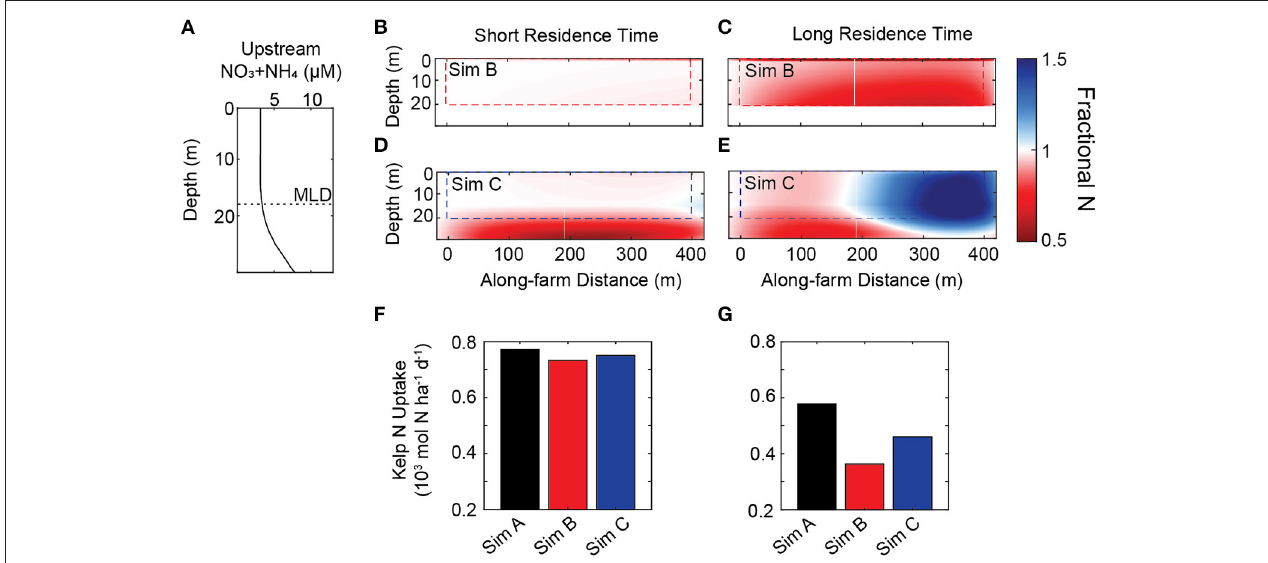
FIGURE 6 | Effect of within-farm nutrient environment on kelp uptake. (A) Upstream nutrient profile used for both residence time demonstrations. Dashed horizontal line indicates depth of the mixed layer. Panels (B–E) illustrate the along-farm fractional change in dissolved nitrogen (NO 3 +NH 4 ) between Simulations B or C relative to upstream conditions on the x − z plane with either short (0.3 h) or long (10 h) residence times on the farm. Simulation B has horizontally-homogeneous transport and kelp uptake effects on nutrient fields. Simulation C includes all within-farm physics, transport, and uptake. Values less than one indicate less dissolved nitrogen relative to upstream conditions at a given depth (red). Values greater than one indicate more dissolved nitrogen relative to upstream conditions at a given depth (blue). The dashed box outlines the region of the water-column populated with kelp (e.g., canopy-forming farm). Nutrient conditions are spatially averaged across a representative growth line ( y -dimension). (F) Total daily nitrogen uptake by kelp for each simulation (spatially integrated across the entire farm and normalized to hectare) with a short residence time. (G) Total daily nitrogen uptake by kelp for each simulation with a long residence